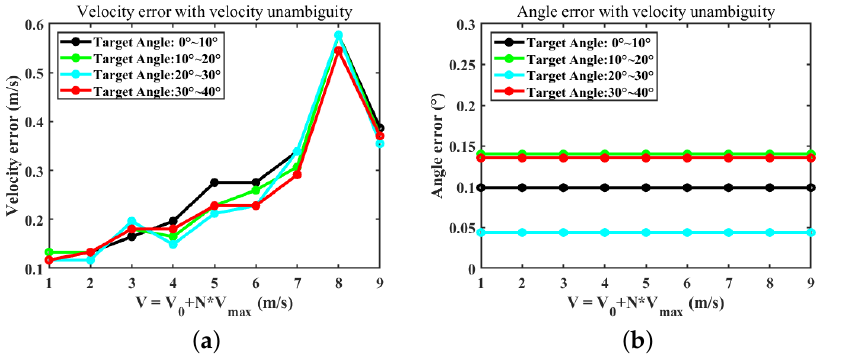
Figure 18. The HPC-Peak algorithm simulation. ( a ) Velocity estimation error. ( b ) Angle estimation error.